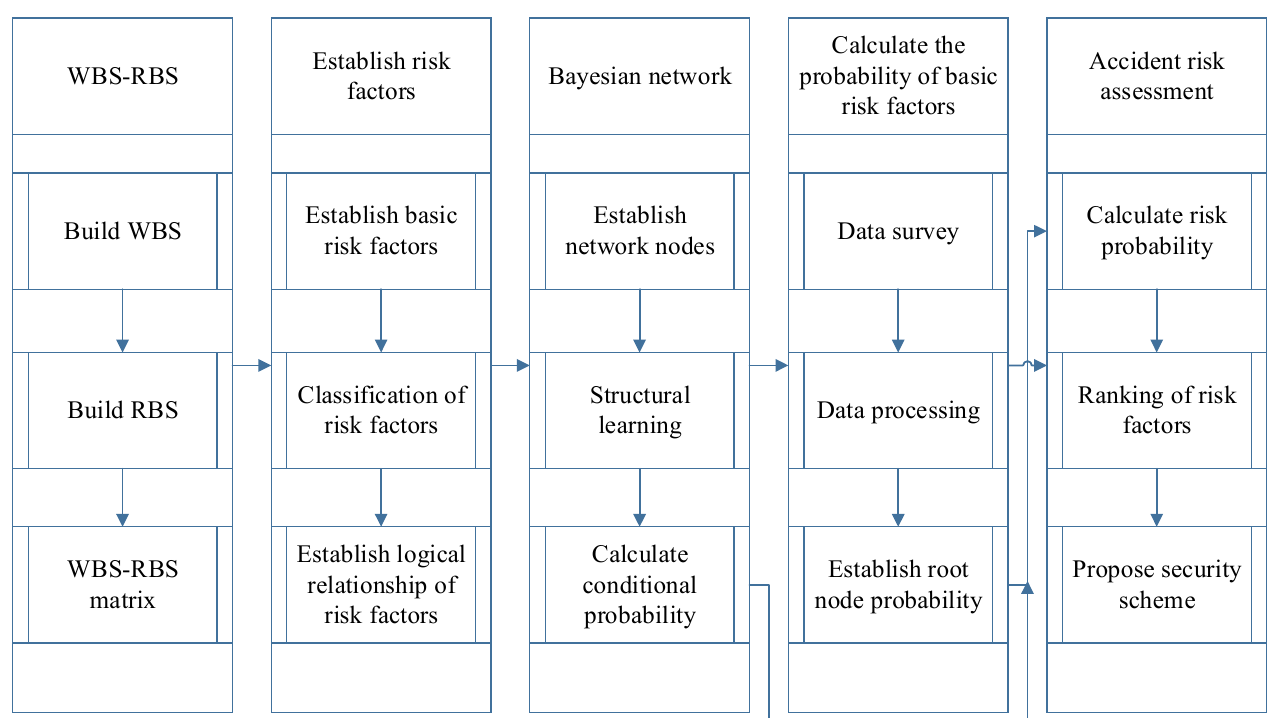
Figure 6. WBS ‐ RBS ‐ BN model analysis flow chart. Figure 6. WBS-RBS-BN model analysis flow